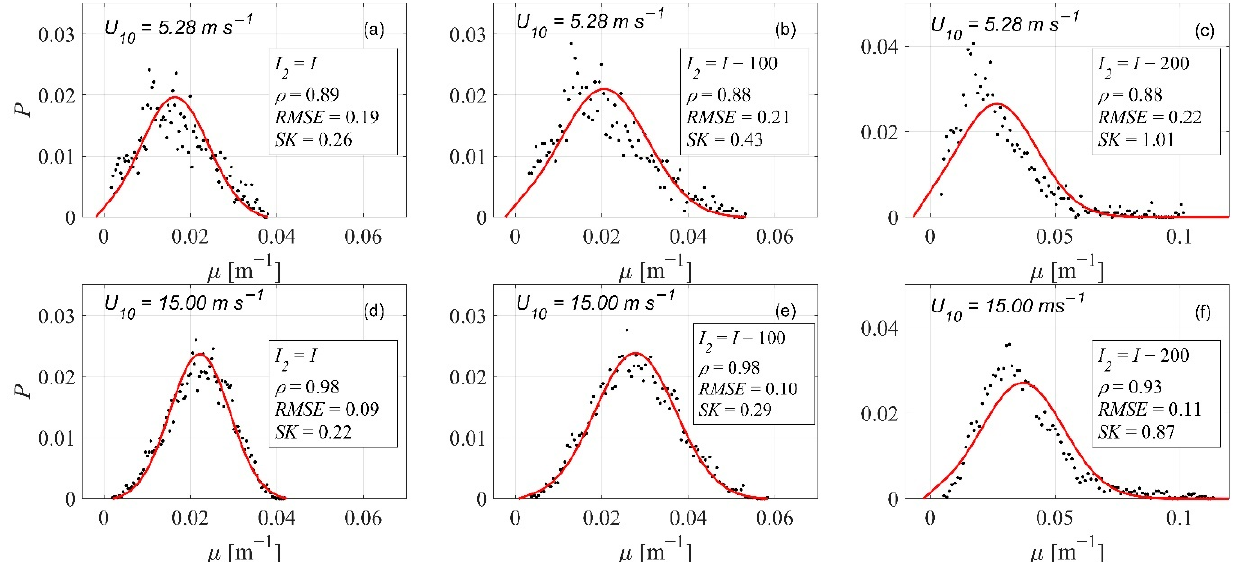
Figure 10. ( a ) An example of the probability density distribution of the laser attenuation coefficient for a 5 m s − 1 wind speed event. Red solid line is Gaussian regression fitting to experimental samples for a 5 m s − 1 wind speed event. ( b , c ) Same as ( a ) but with artificially reduced laser intensity of 100, and 200 W s − 2 , respectively. ( d ) An example of the probability density distribution of the laser attenuation coefficient for a 15 m s − 1 wind speed event. Red solid line is Gaussian regression fitting to experimental samples for a 15 m s − 1 wind speed event. ( e , f ) Same as ( d ) but with artificially reduced laser intensity of 100, and 200 W s − 2 ,